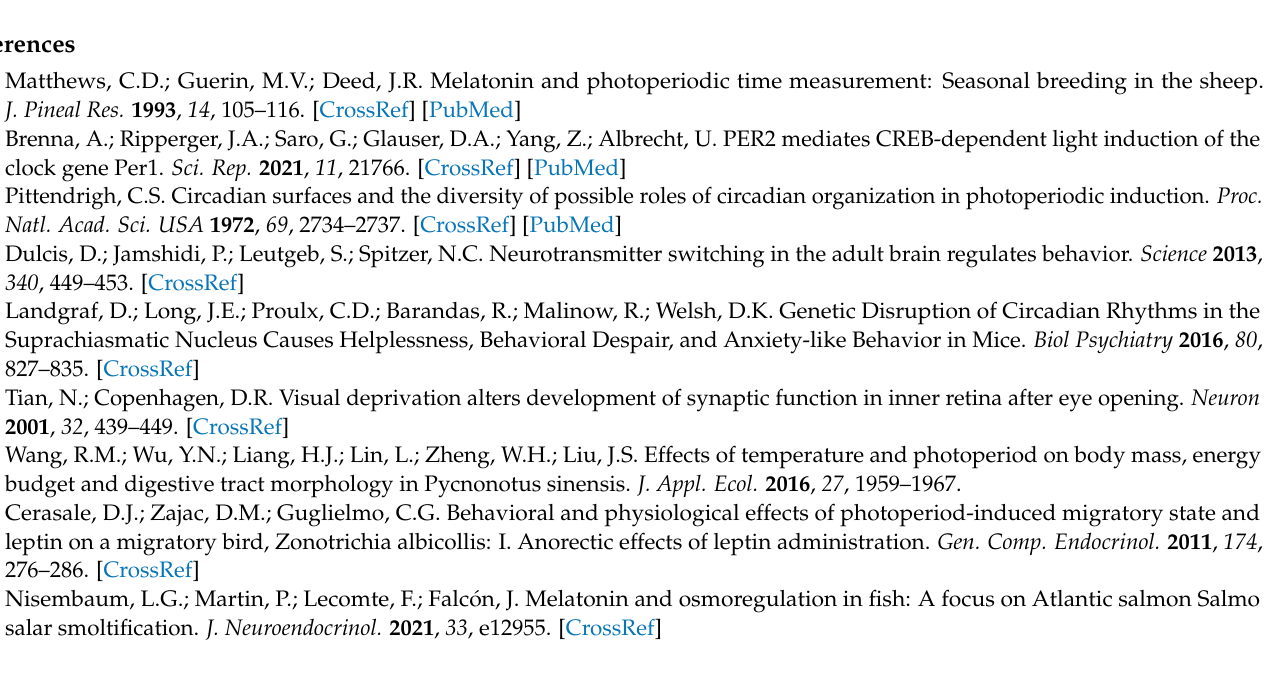
mRNA and miRNAs reads. Table S2: Introduction of mRNA. Table S3: Introduction of miRNA. Table S4: Differentially expressed mRNAs in long photoperiods to short photoperiods were iden- tified in hypothalamic and distal pituitary. tissues. Table S5: Differentially expressed miRNAs in long photoperiods to short photoperiods were identified in hypothalamic and pituitary tissues. Table S6: GO and KEGG enrichment annotation for mRNAs in hypothalamus. Table S7: GO and KEGG enrichment annotation for mRNAs in distal pituitary. Table S8: Crossover genes GO and KEGG between predicted target genes of DEGs and DEMs in the hypothalamus. Table S9: Crossover genes GO and KEGG between predicted target genes of DEGs and DEMs in the distal pituitary. Table S10: Construction of miRNA-mRNA Interaction Network in hypothalamus. Table S11: Con- struction of miRNA-mRNA Interaction Network in distal pituitary. Table S12: Summary of changes in the genes of the hypothalamus and pituitary